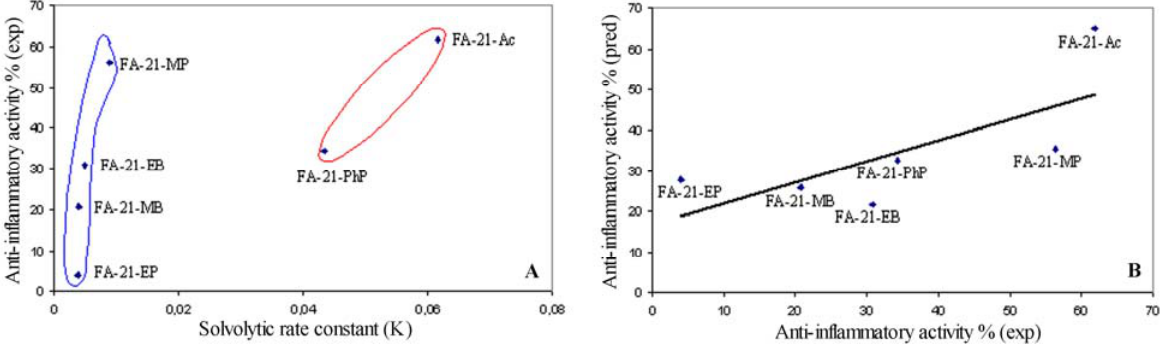
Figure 3. A. Experimental anti-inflammatory activity versus solvolytic rate constant. B. Predicted versus experimental anti-inflammatory activity of fluocinolone acetonide C-21